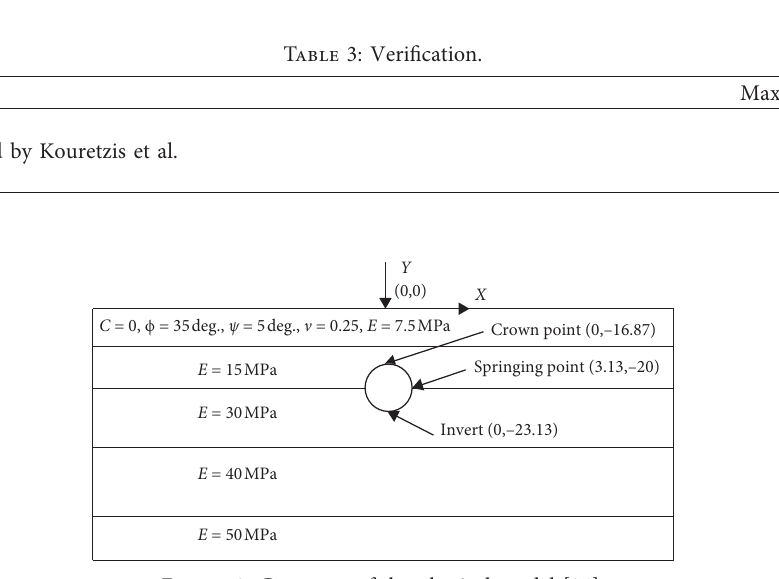
Figure 2: Geometry of the physical model [24]. Table 4: Variation of elastic modulus of Delhi silt with depth [25].